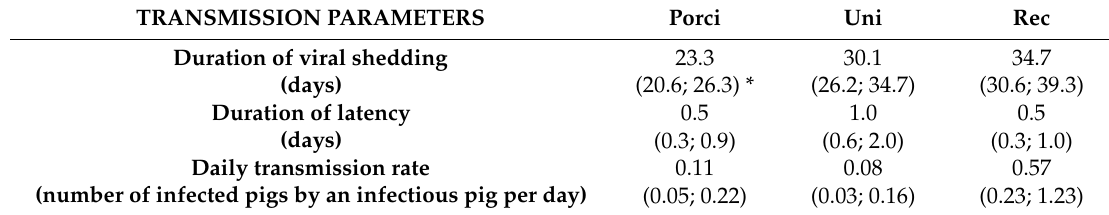
Table 1. Estimation of transmission parameters in the Porci, Uni, and Rec groups.